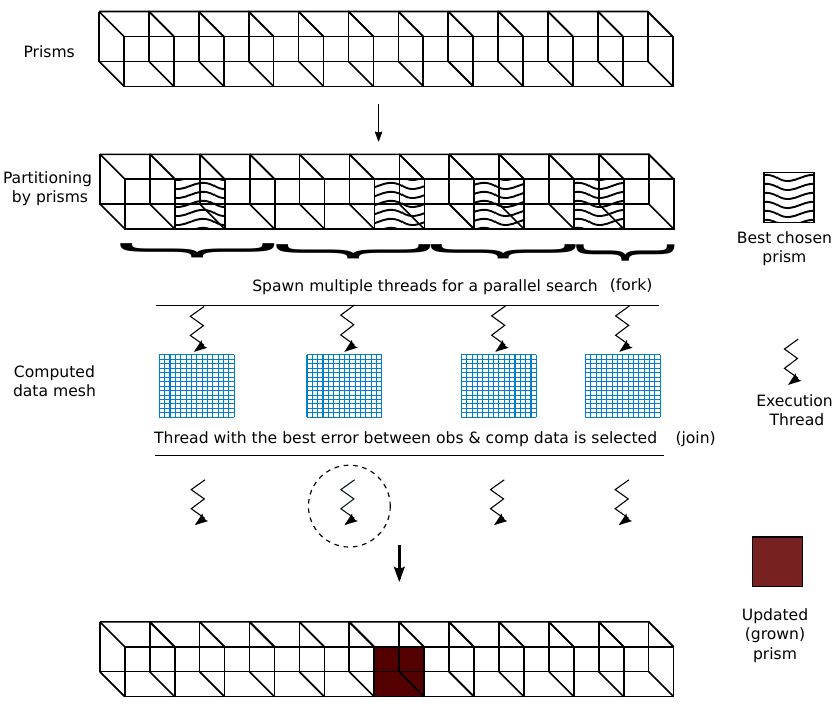
Figure 3. Parallelization scheme for the inversion process by growth of